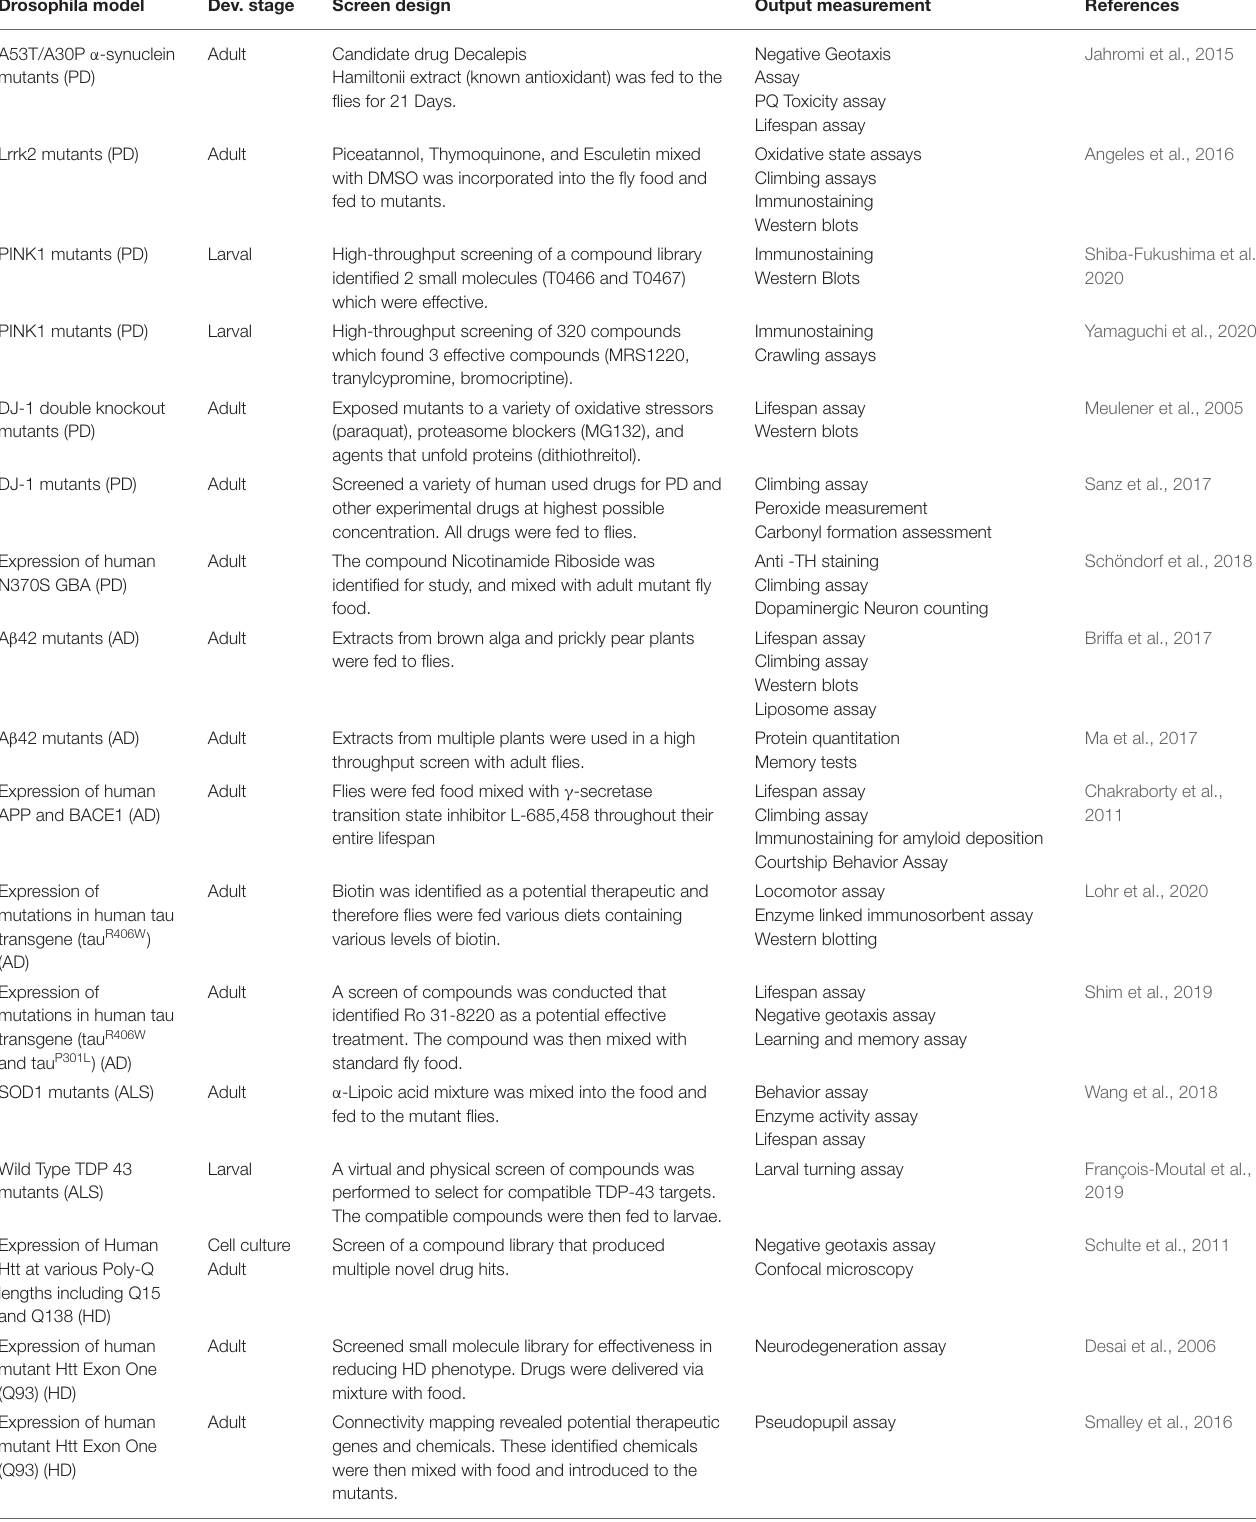
TABLE 2 | D. melanogaster models of ND used for small molecule